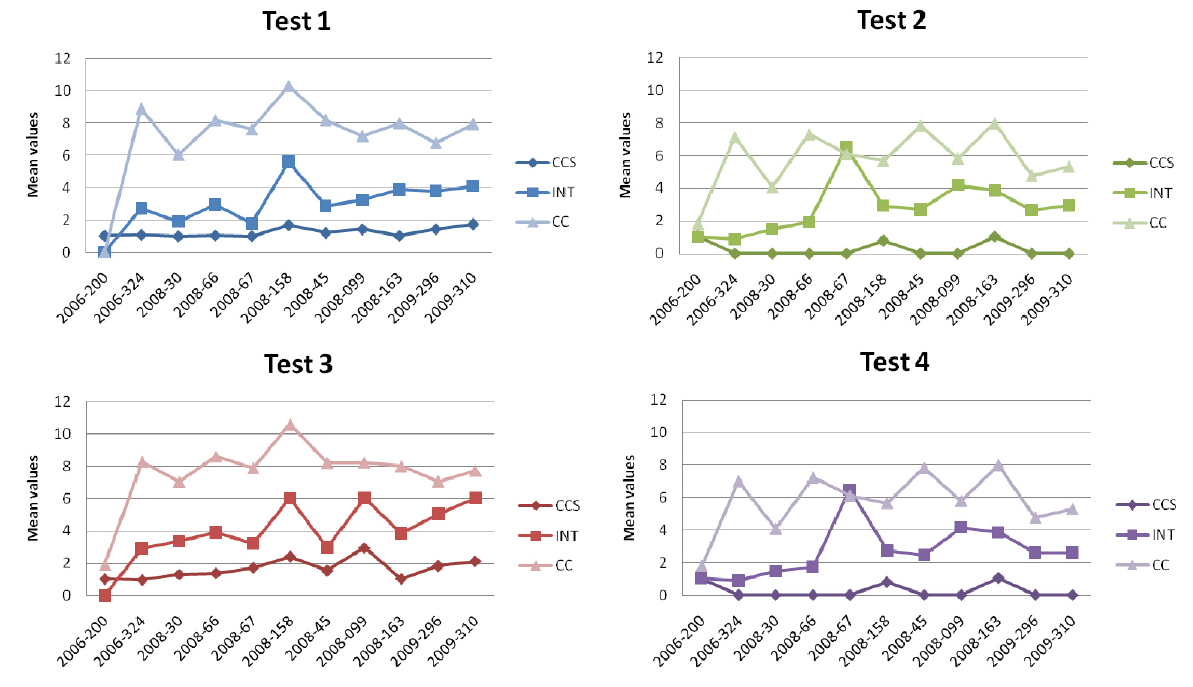
Figure 4. Mean values of the cloud profiles from CloudSat ( y axis) based on the different thresholds from tests 1, 2, 3 and 4 considering the following classes: Confident Cloudy (CC), Confident Clear Sky (CCS) and INT (Intermediate). The dates of the images are reported on the x